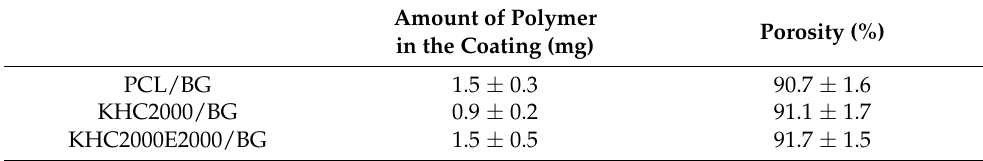
Table 4. The average amount of polymer covering the composites and porosity after